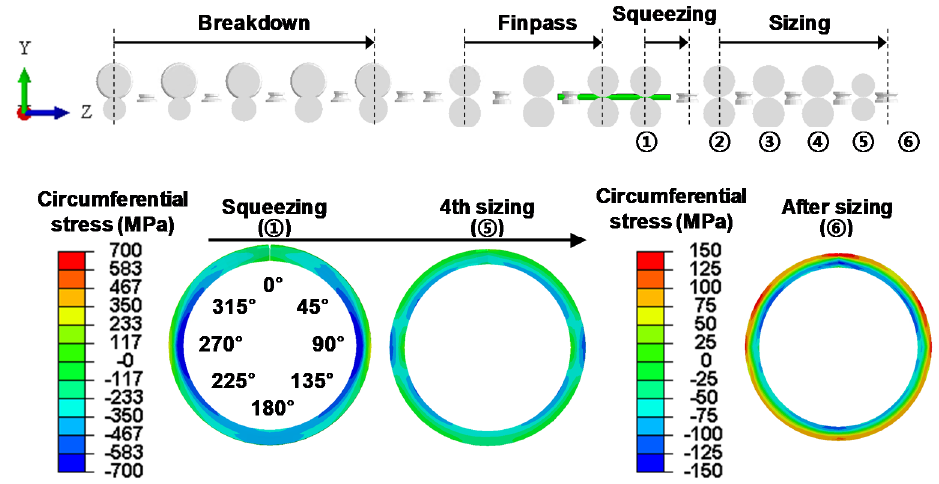
Figure 6. Distribution of circumferential stress along the circumferential direction in squeezing and sizing processes.